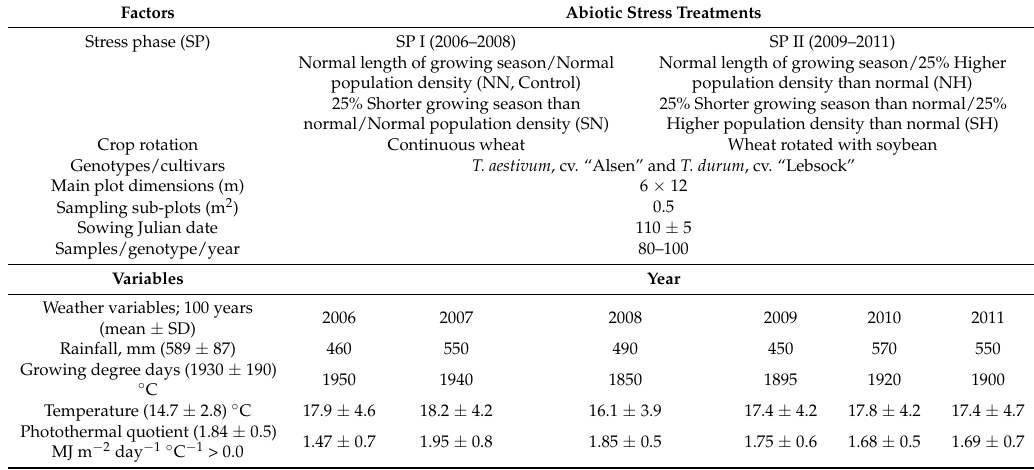
Table 1. Design of a factorial field experiment evaluating durum ( T. durum ; cv. “Alsen”) and bread ( T. aestivum ; cv. “Lebsock”) wheat genotypes in a randomized complete plot design, including abiotic stress phases, treatments, factors, meteorological data, and experimental units for six years